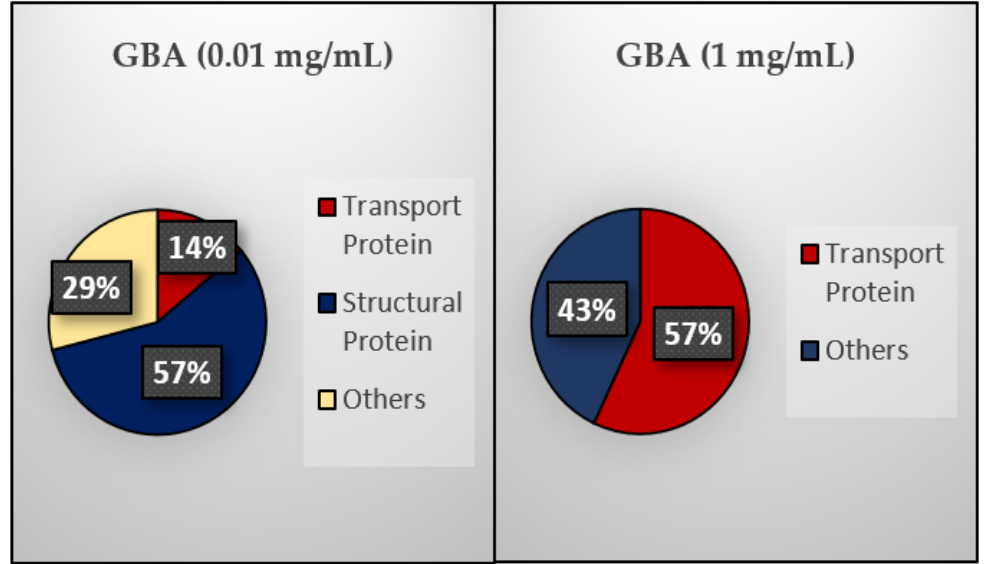
Figure 12. Taxonomy (%) of proteins based on their biological functions.